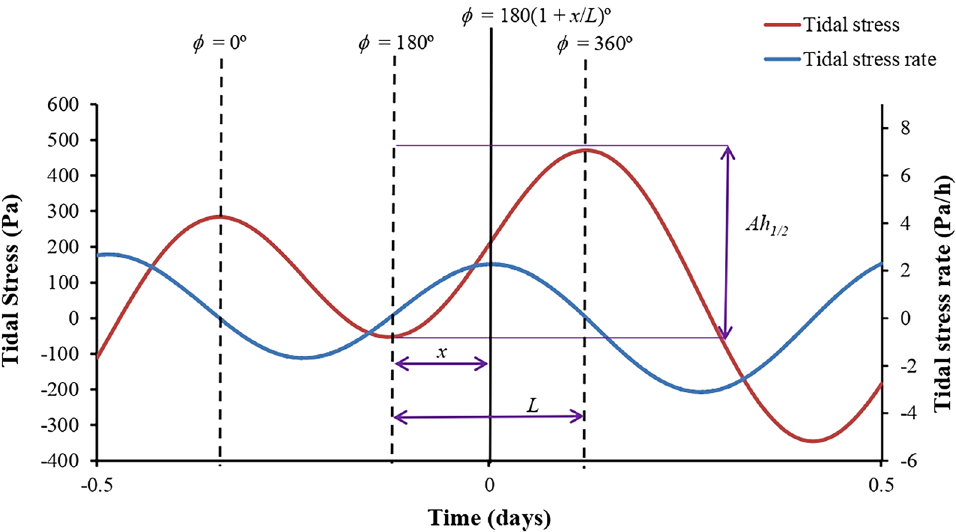
Figure 3. Schematic of the tidal phase method 48 . The terms Ah 1/2 and L are the amplitude and time length of the half cycle in which the event occurs, respectively. x is the time difference between the occurrence time of the earthquake and phase ϕ = 180°, positive when the event occurs after phase ϕ = 180° and negative when it happens prior to phase ϕ = 180°. The tidal stress rate is shown as the blue line. Note that maximum increasing tidal stress rate occurs around tidal stress phase ϕ = 270°, whereas maximum decreasing tidal stress rate happens around tidal stress phase ϕ = 90°.